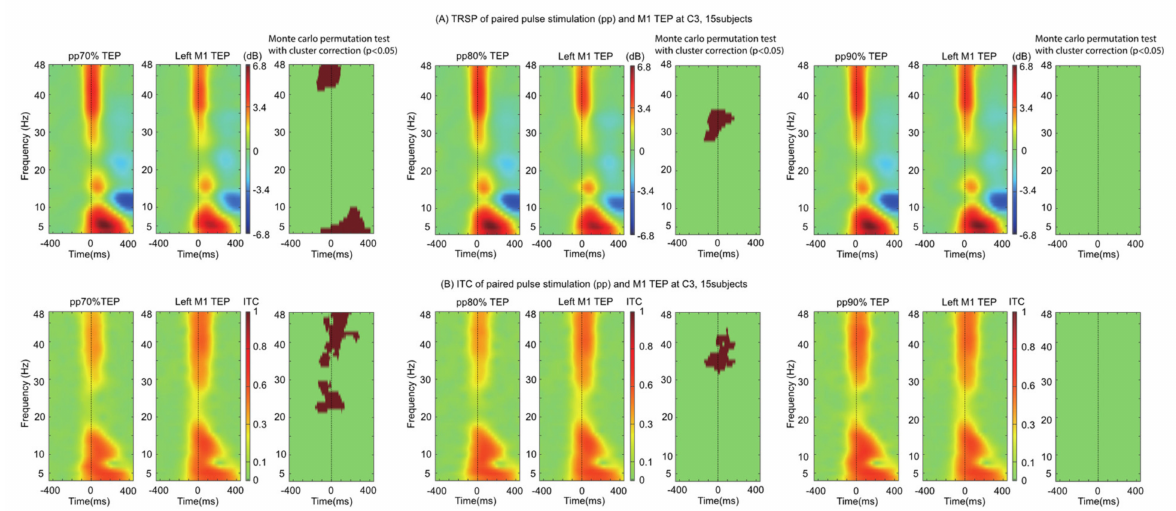
Figure 3. TEP-related spectral perturbation (TRSP) and intertrial coherence (ITC) of spTMS and ppTMS 70, 80, 90 conditions for the C3 electrode. Top row ( A ) shows the 5-48 Hz TRSP with warmer colors depicting greater power and cooler colors depicting lower power. Bottom row ( B ) shows ITC, where values vary from 0 to 1 (1 represents perfect coherence between trials, whereas 0 represented no coherence between trials). Monte Carlo permutation tests with cluster correction are performed and shown adjacent to TRSP/ITC plots. Threshold for statistical significance is set to 0.05. Each ppTMS condition is paired with the spTMS (Left M1 TEP) condition to facilitate